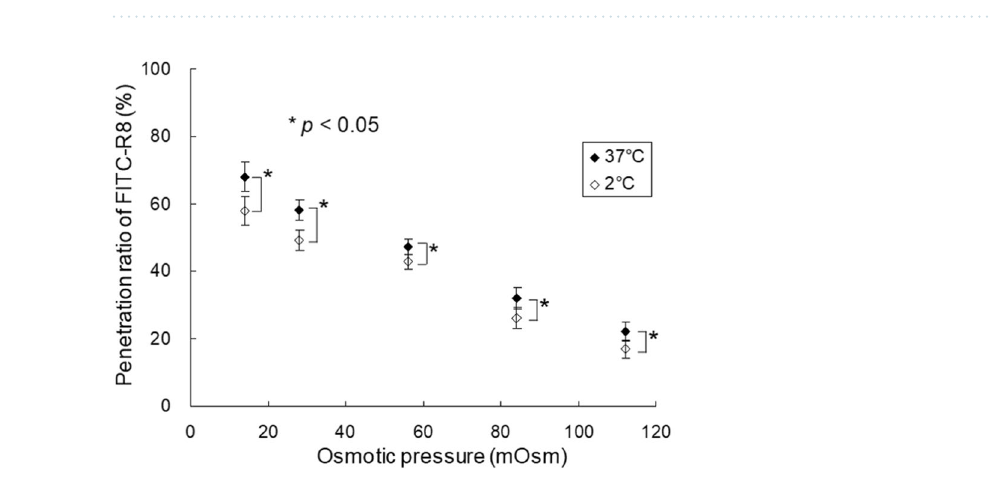
Figure 5. Effect of Osmotic pressure on the cytolysis of FITC-R8 (CPP) to the GUVs with varieties of Phospholipids (DOPC,POPC and EPC) (L/P = 1000, 10 min, 37 °C, n = 5).